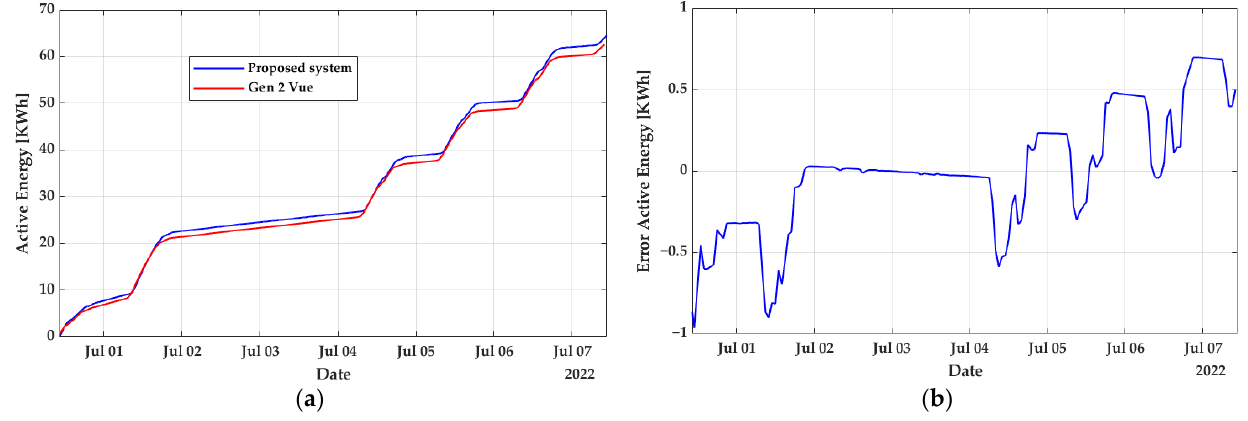
Figure 18. Active energy in line 1: ( a ) comparison between the proposed system and the commercial monitor; ( b ) measurement errors of the proposed system with respect to the commercial monitor.